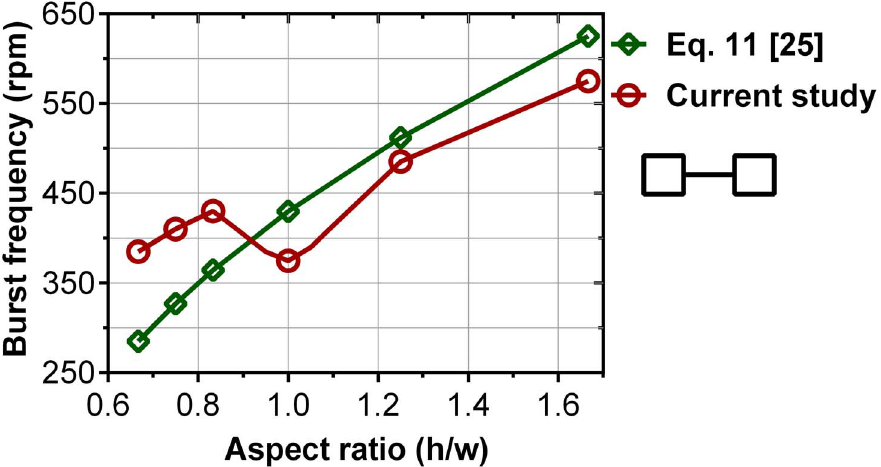
Figure 5. Burst frequency of the CFD model and Eq. 11 [ 25 ] versus aspect ratio for Cases 5–10.